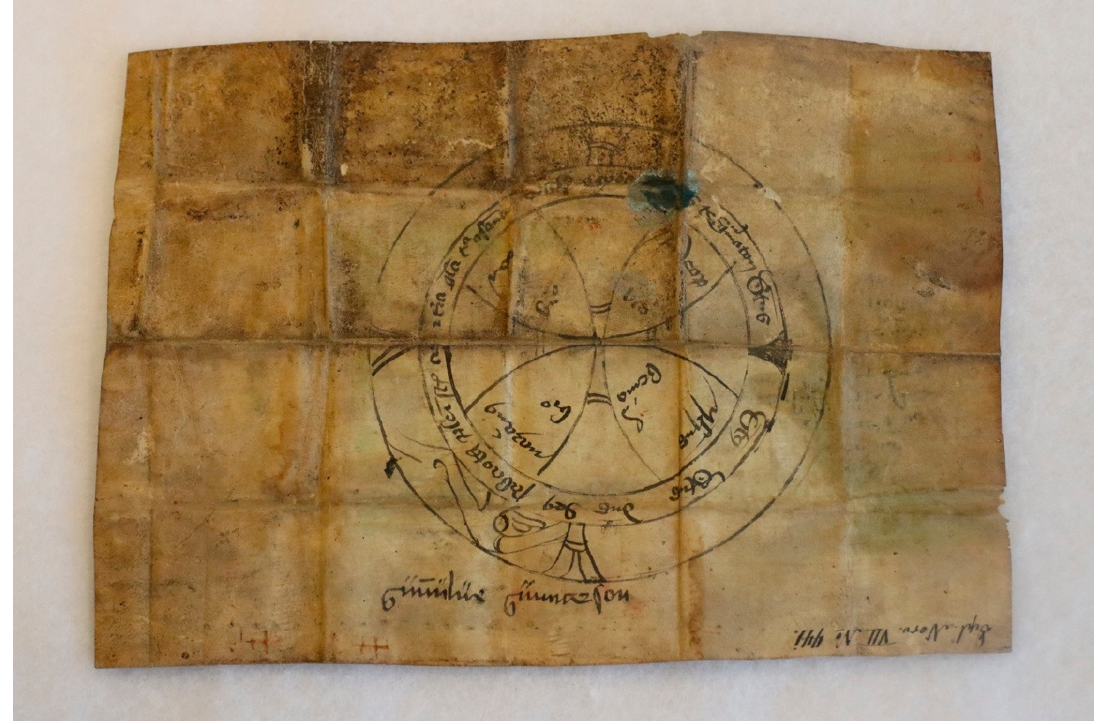
Figure 5. Amulet from Aust Agder, cross ornament. Ink on parchment, 1400–1450. Photo: Kaja M. H. Hagen.